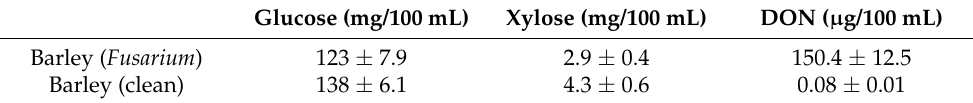
Table 3. Initial characteristics of F. graminearum contaminated barley mashes.